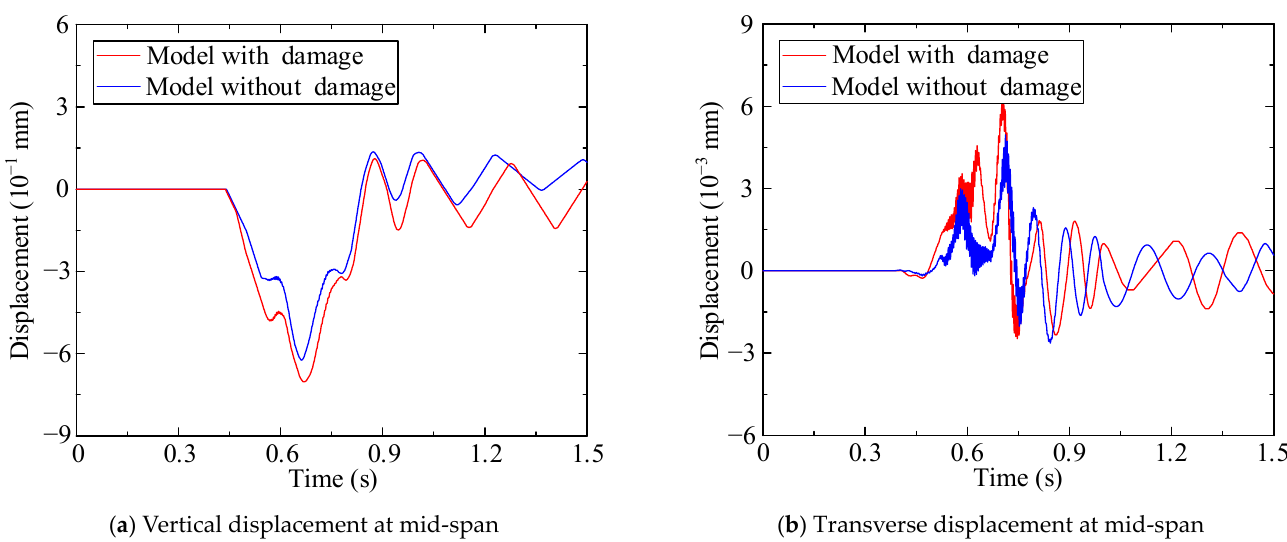
Figure 28. Responses of the composite beam at a train speed of 300 km/h in the case of